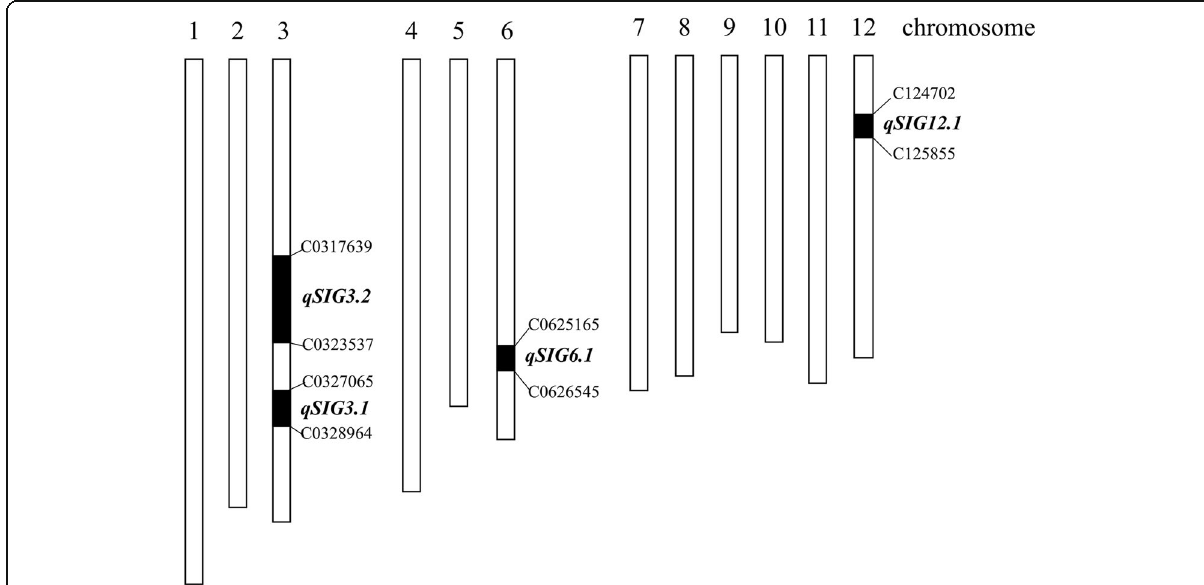
Fig. 2 Location of four QTLs on chromosomes. Markers were named after their physical location on the chromosome. For example, C0317639 indicates that the marker is at 17,639 kb on chromosome